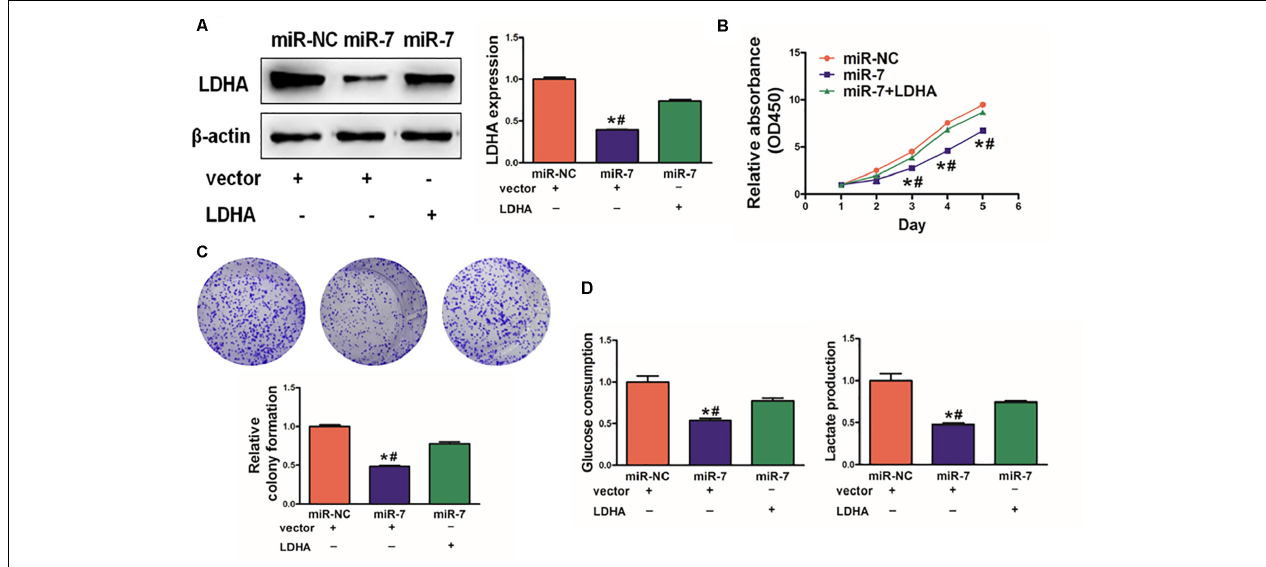
FIGURE 4 | LDH-A overexpression overcomes the inhibition effects of miR-7. (A) LDH-A expression was increased via plasmid transient transfection, 72 h later, protein were extracted, and results as shown. (B) When miR-7 was overexpressed, cell proliferation decreased, whereas co-overexpression of LDH-A rescued this phenotype. (C) A colony formation assay was performed with the indicated cells. (D) Glucose utilization and lactate production were assessed for all indicated cells. Data are means ± SD. * P < 0.05 vs control; # P < 0.05 vs miR-7 and LDH-A overexpression. ** P < 0.01.